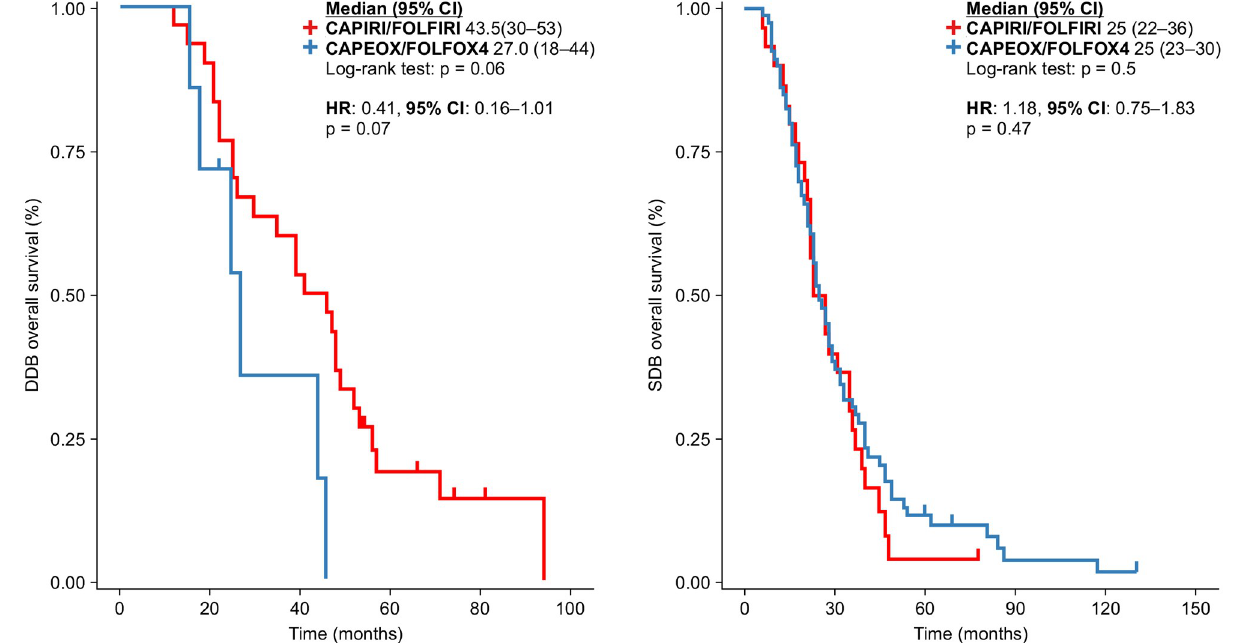
Fig 3. Overall survival, according to the first-line backbone chemotherapy in the double-dose and standard-dose bevacizumab groups.